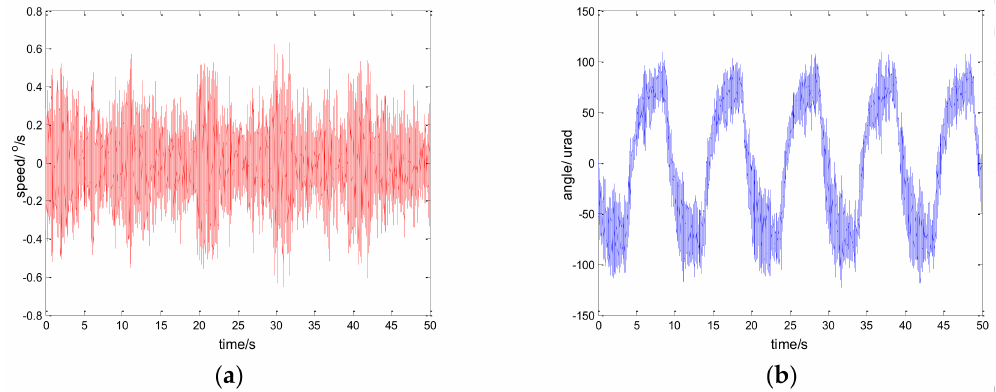
Figure 12. Experiment results of PI control. d = 3sin ( 2 π × 0.1 t ) : ( a ) speed; and ( b ) tracking error, RMS = 60.6991 urad.